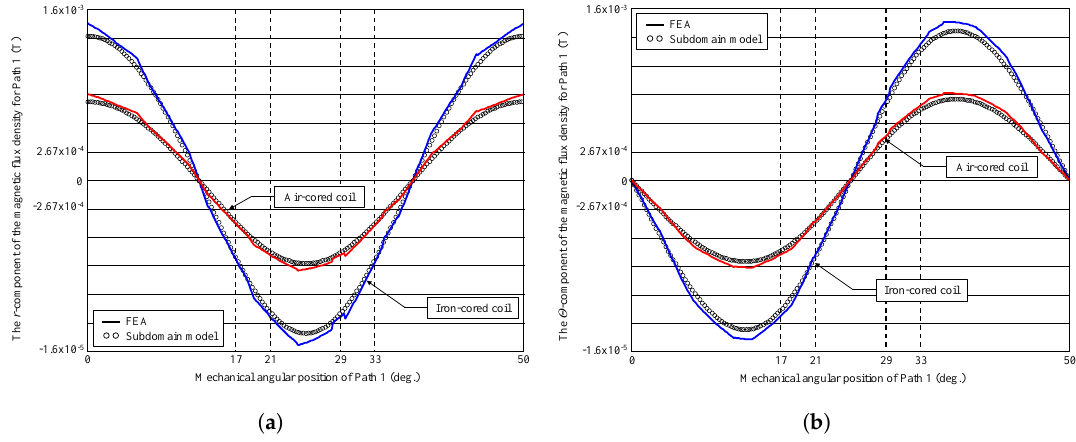
Figure 7. Waveforms of B for Path 1: ( a ) r - and ( b ) Θ -component.